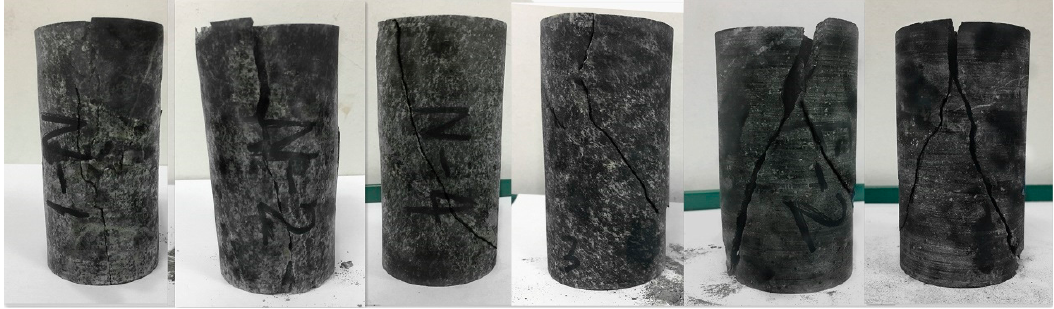
Figure 8. Images of failure in rock samples after different numbers of dry-wet cycles.